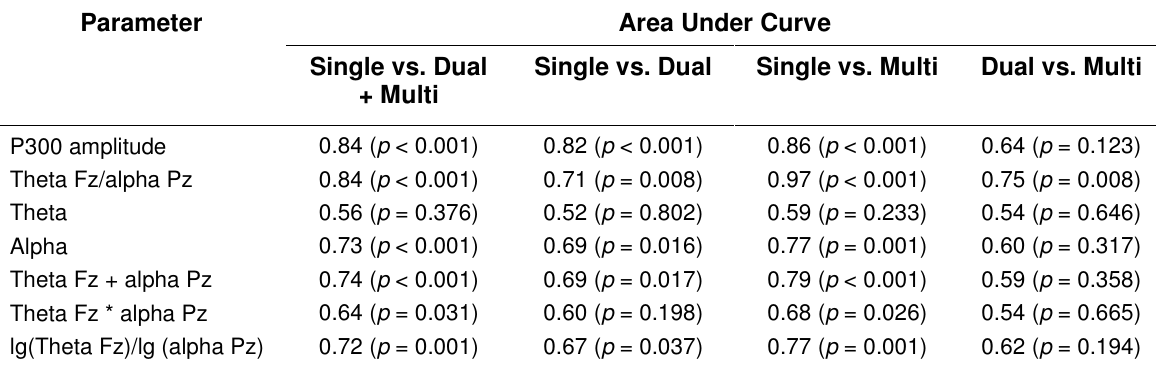
The Comparison of Different Brain Load Metrics* Area Under Curve Parameter Single vs. Dual Single vs. Dual Single vs. Multi Dual vs.